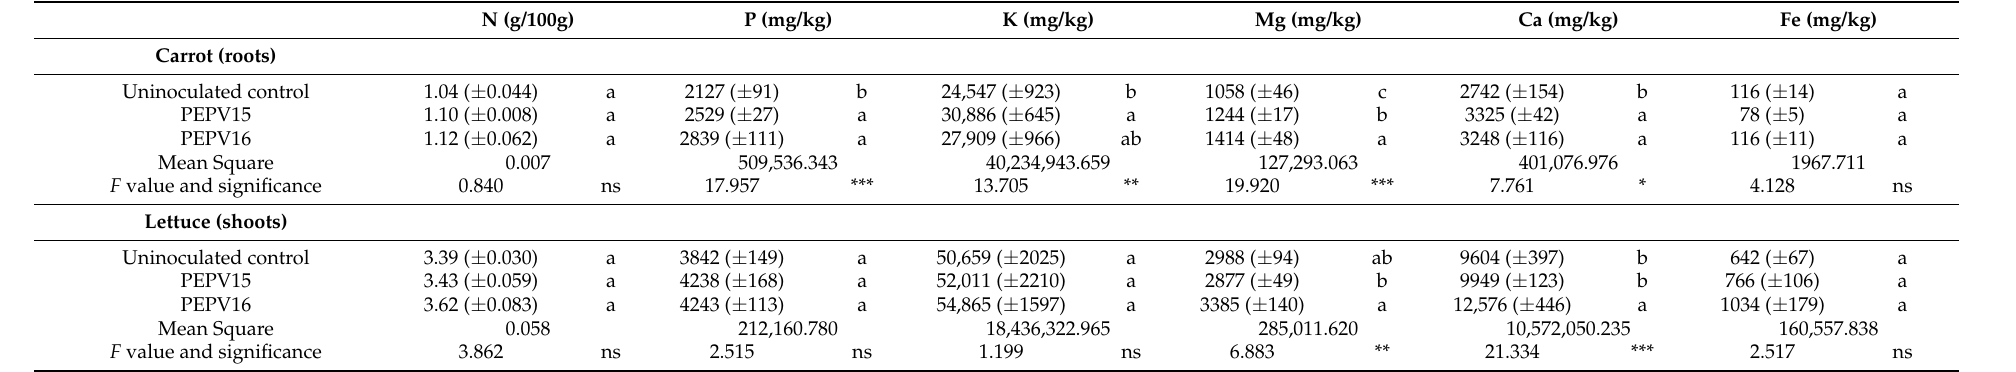
Table 5. Mean values and standard errors corresponding to the mineral content in the roots and shoots produced by carrot and lettuce crops, respectively, after the inoculation with the strains PEPV15 and PEPV16 and in the uninoculated controls in the field experiment. The values followed by the same letter did not significantly differ in the Tukey test. ANOVA was performed with blocks as a random factor and the treatment as a fixed factor ( p -value: *** p ≤ 0.001; ** 0.001 < p ≤ 0.01; * 0.01 < p ≤ 0.05: ns, not significant). N (g/100g) P (mg/kg) K (mg/kg) Mg (mg/kg) Ca (mg/kg) Fe